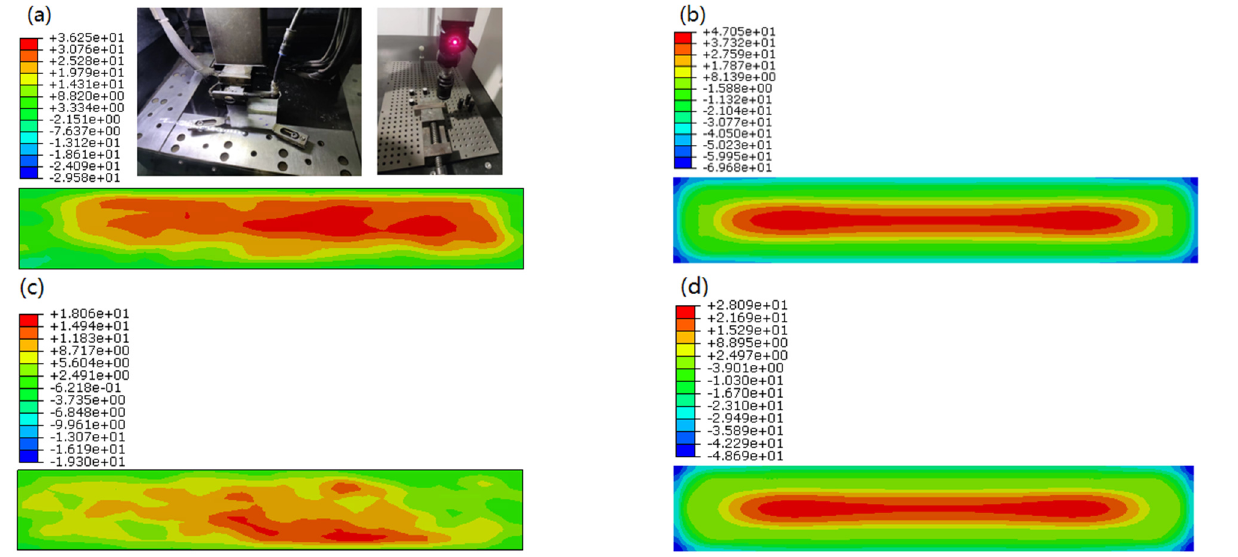
Figure 12. Inner RS of ( a ) experimental results in WQ (20 °C), ( b )simulation results in WQ (20 °C), ( c ) experimental results in WQ (100 °C) and ( d )simulation results in WQ (100 °C) in contour meth- od.